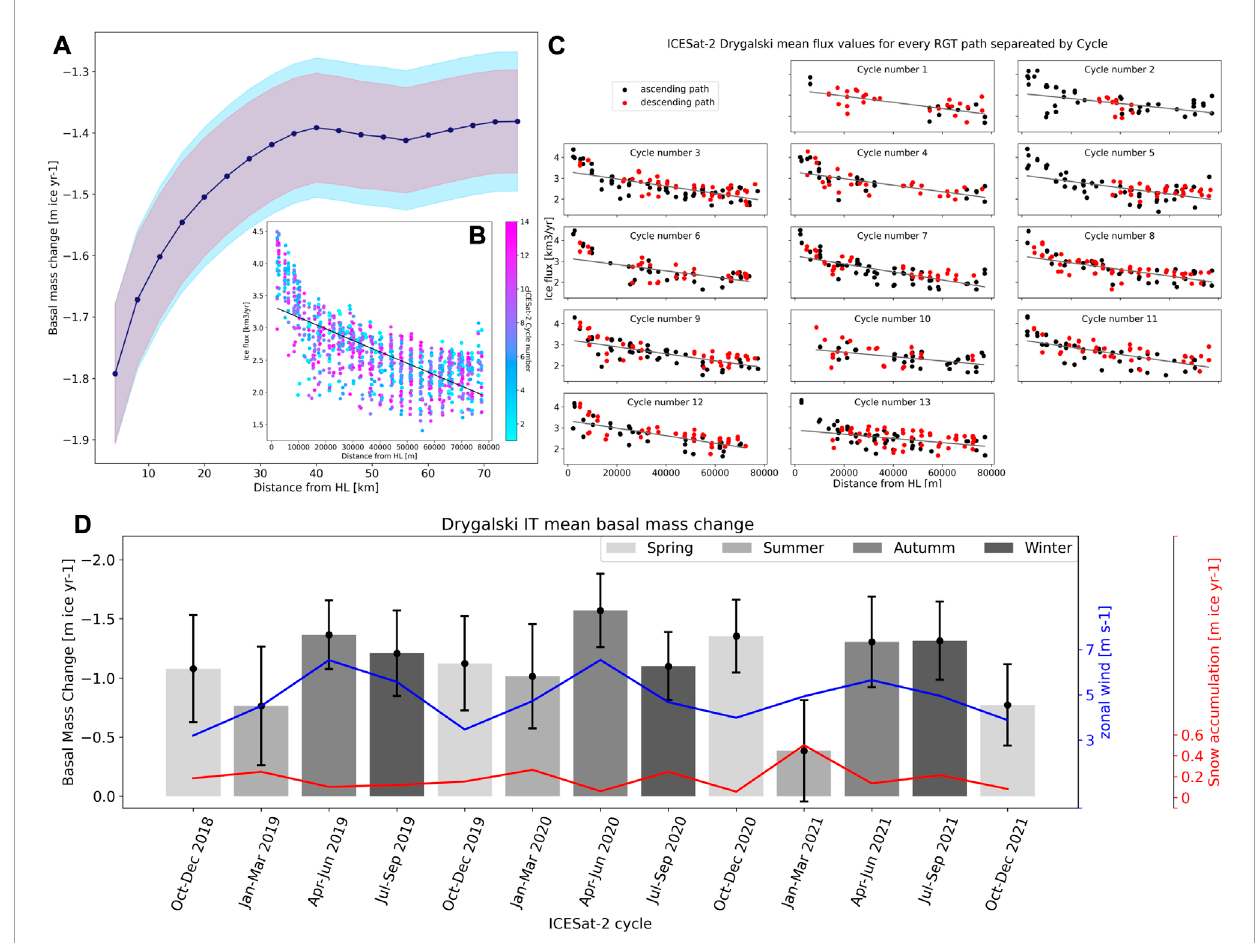
FIGURE 5 Drygalski (A) Basal melt between flowlines over the free-floating area of the ice tongue, derived from all the ICESat-2 data. The basal melt derived from the linear model confidence interval is shown in red, and the standard deviation of the basal melt is in light blue. (B) Ice flux derived from all cycles with fitted linear regression in black. The different cycles are shown in a colour map from cycle-1 in light blue to cycle-13 in pink. (C) Ice flux per cycle for every ICESat-2 track, with red showing the descending tracks and in black the ascending tracks. Every cycle has a fitted linear regression shown in grey. (D) Drygalski spatially averaged basal melt rates, with the axis inverted for clarity. Where more negative numbers imply larger mass loss, and the different seasons are depicted in a grey colour scheme. With darker grey for winter and lighter grey for summer. The snow accumulation rate in m of ice over the same period is shown in red. The snow accumulation values are derived from ERA5-land and are scaled to the same period as the ICESat-2